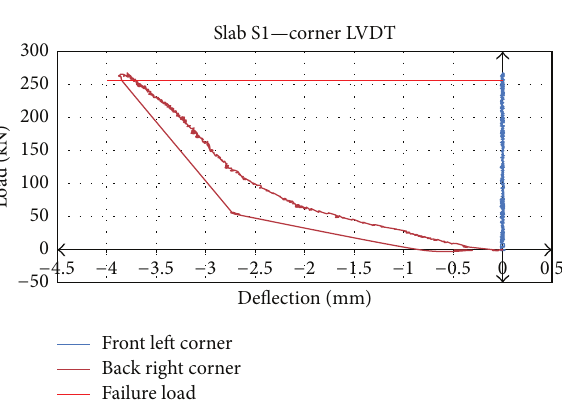
Figure 26: Load V’s corner deflection on slab